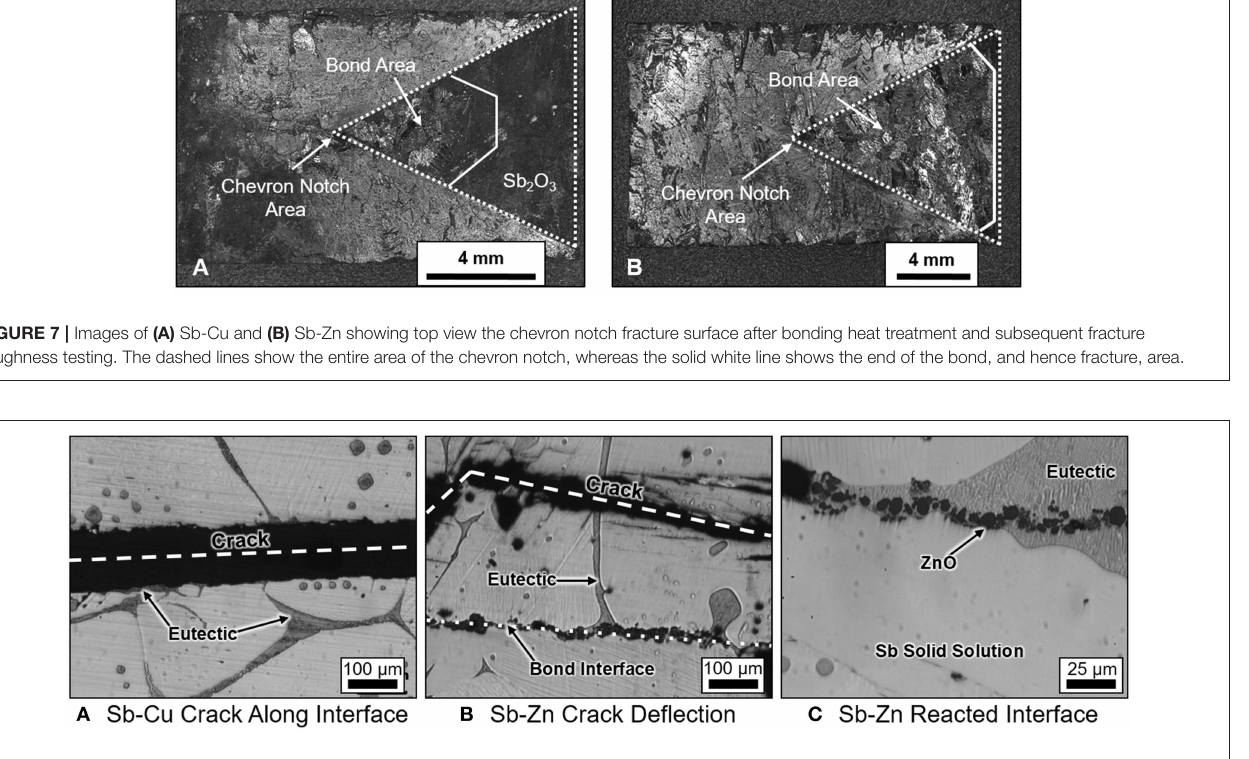
FIGURE 8 | Representative micrographs of (A) Sb-4at% Cu and (B) Sb-4at% Zn showing fracture line after bonding. Note that the Sb-Zn alloys had fractures occur away from the bonded interface. (C) Image of the Sb-4at% Zn bonded microstructure highlighting ZnO along the bond interface formed by the reduction of Sb 2 O 3 by Zn.